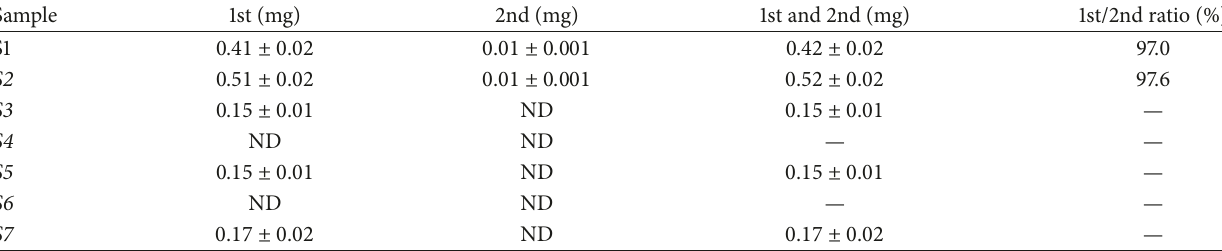
Table 3: The amounts of javamide-I in seven green coffee samples. Seven green coffee extract samples (S1–S7) as described in Table 1 were individually extracted twice with 70% MeOH extracts (50mL), providing the 1st and 2nd extracts. The amounts of javamide-I were presented as mg per 1g green coffee sample ( 𝑛 = 5 ).